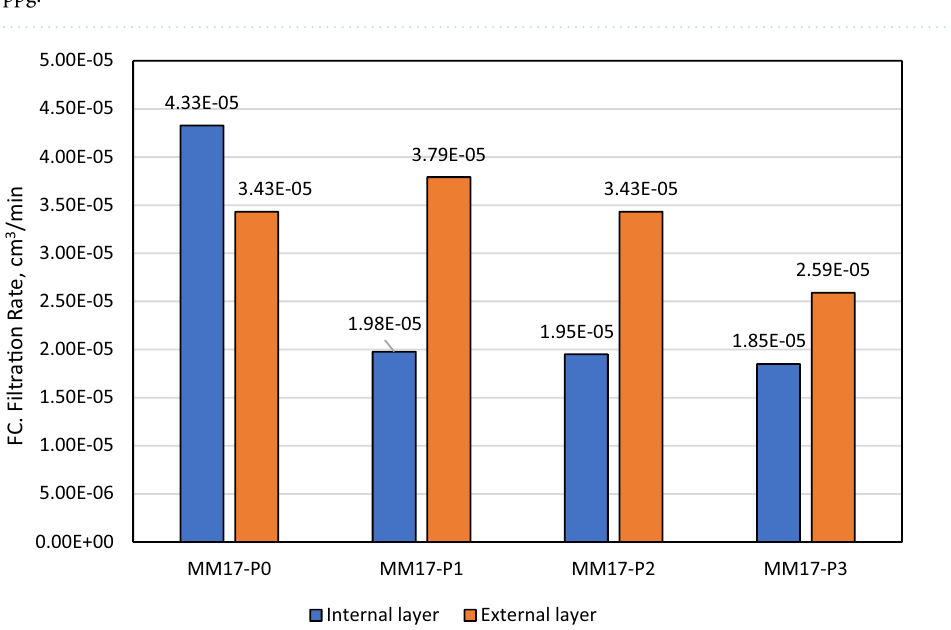
Figure 4. Filter cake rate for internal and external layers as function of perlite concentration for mud density equal to 17.2